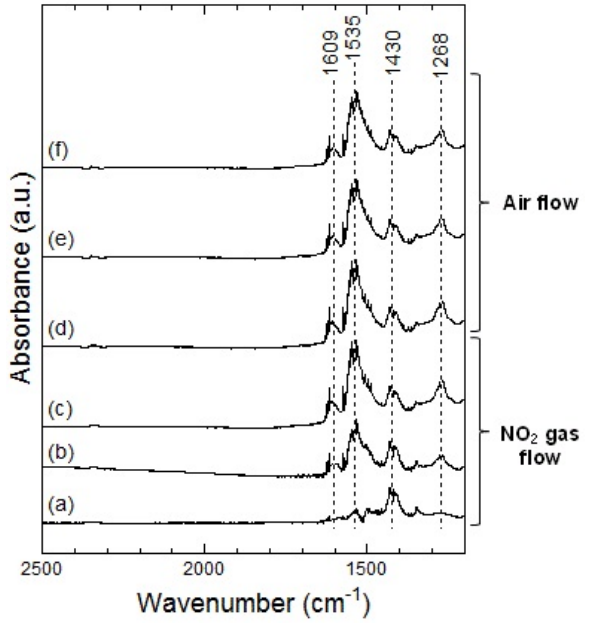
Figure 11. DRIFT spectra of Co O powder at 100 °C. The powders were exposed to 3 4 in air for ( a ) 2 min, ( b ) 20 min, and ( c ) 50 min. After NO 1 ppm of NO 2 powders were purged by air for ( d ) 1 min, ( e ) 30 min, and ( f ) 60 min.